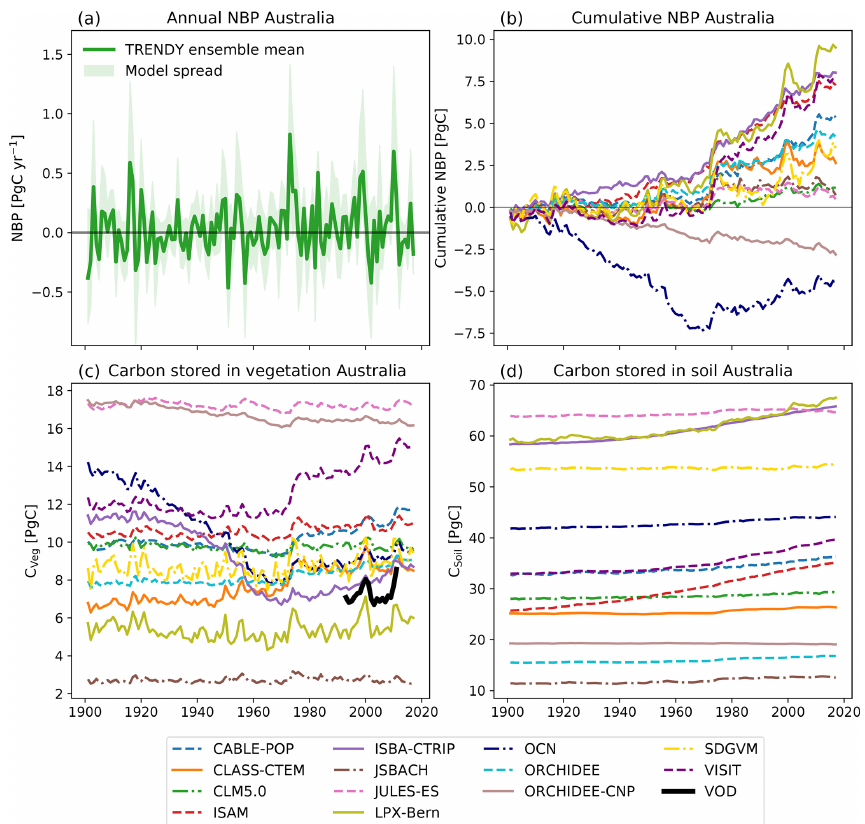
Figure 1. Net biome production (NBP), carbon stored in vegetation ( C Veg ), and carbon stored in soil ( C Soil ) for the TRENDY model ensemble for the CO 2 + CLIM + LUC run. Positive values in NBP represent a net carbon sink; negative values are a net carbon source. The solid green line in (a) shows the ensemble mean of total annual NBP, and the shaded green area shows the range across models. Panel (b) shows the cumulative net biome production for each model summed over Australia. Panels (c) and (d) show C Veg and C Soil respectively summed over Australia for each model. The black line in (c) shows the a satellite-derived estimate (“VOD”; Liu et al., 2015). Note that we define the first month of the year as July and the last month of the year as June for NBP and follow calendar years for the carbon